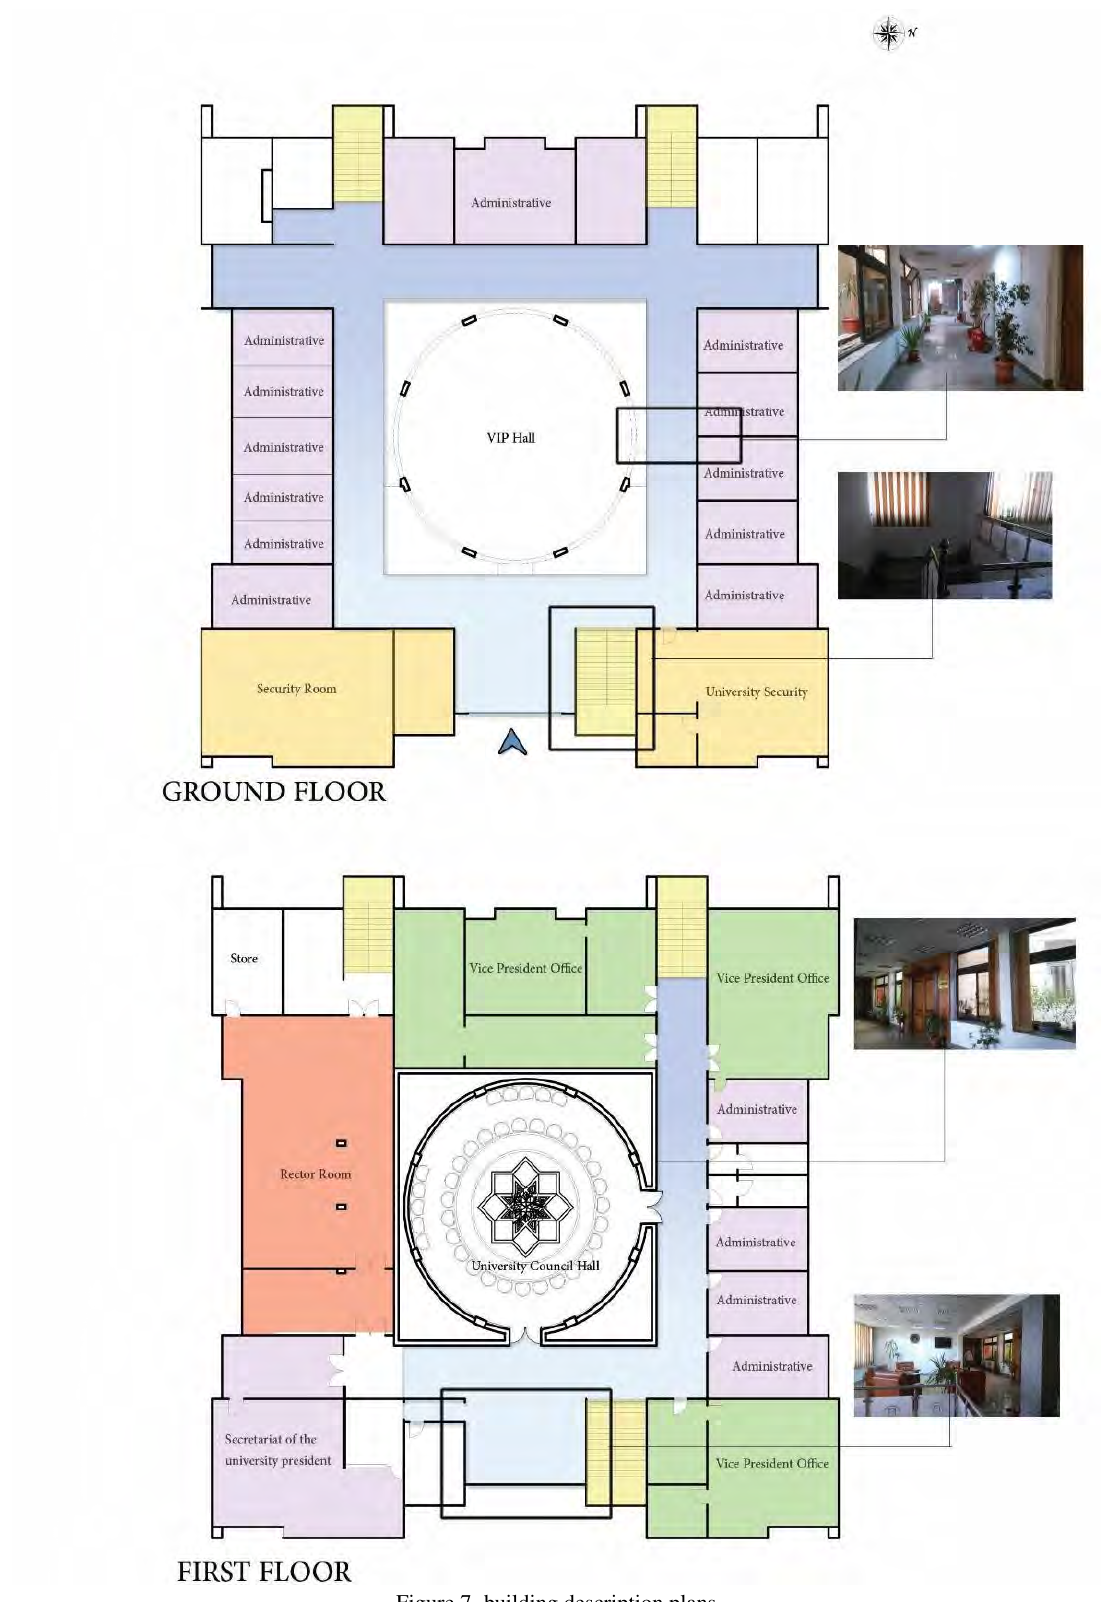
Figure 7. building description